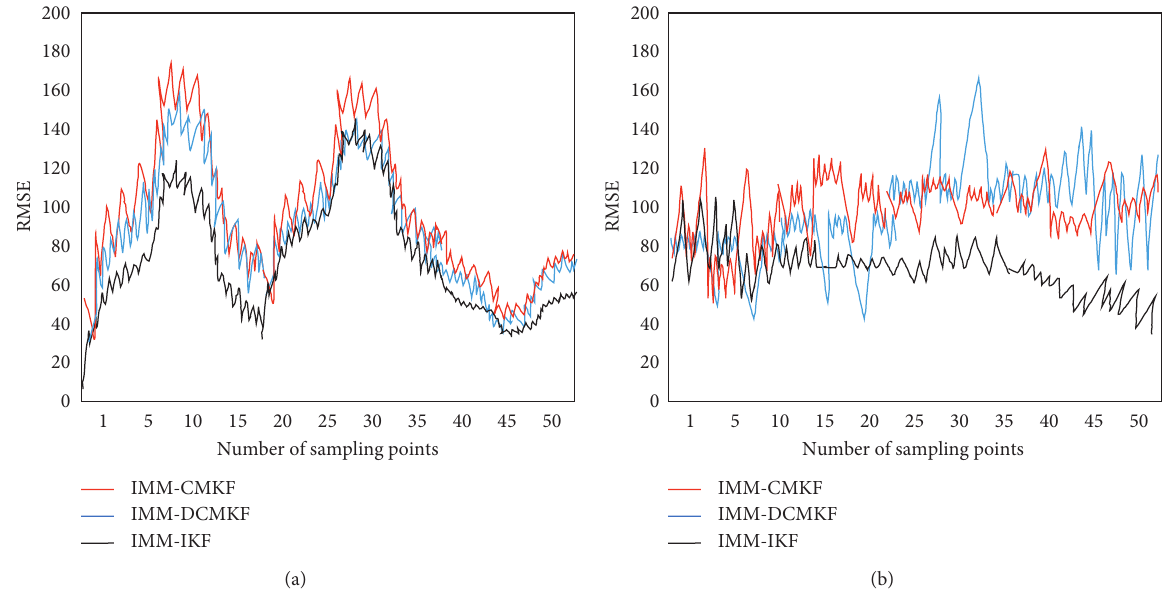
Figure 7: Comparison of the root mean square error of the position in the X and Y directions on the CS model. (a) Root mean square error of position in x direction. (b) Root mean square error of position in y direction.